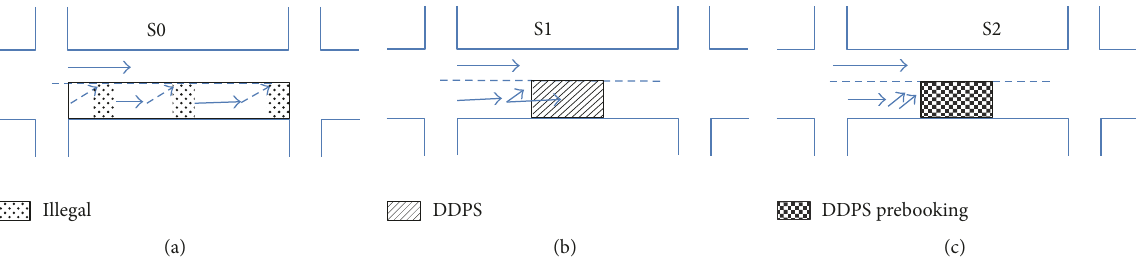
Figure 8: (a) S0, illegal parking with random arrival and location; (b) S1-DDPS; (c) S2-DDPS with prebooking system.